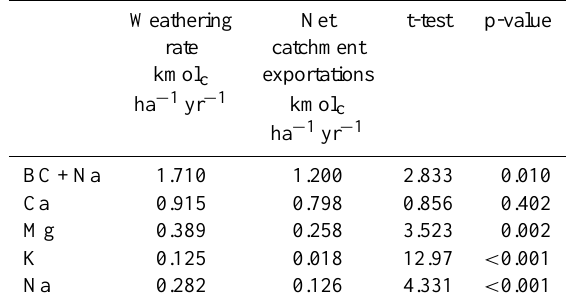
Table 7. Average of weathering rate and net catchment exportation for BC+Na, Ca, Mg, K and Na and results of paired t-test between the two variables ( n